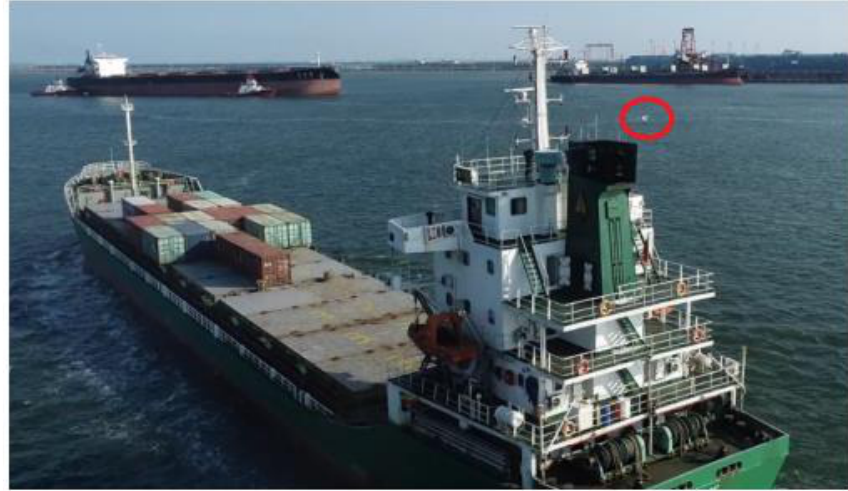
Figure 4. Image of UAV on-site tracking ship. The red ellipse indicates the actual monitoring position of the UAV .